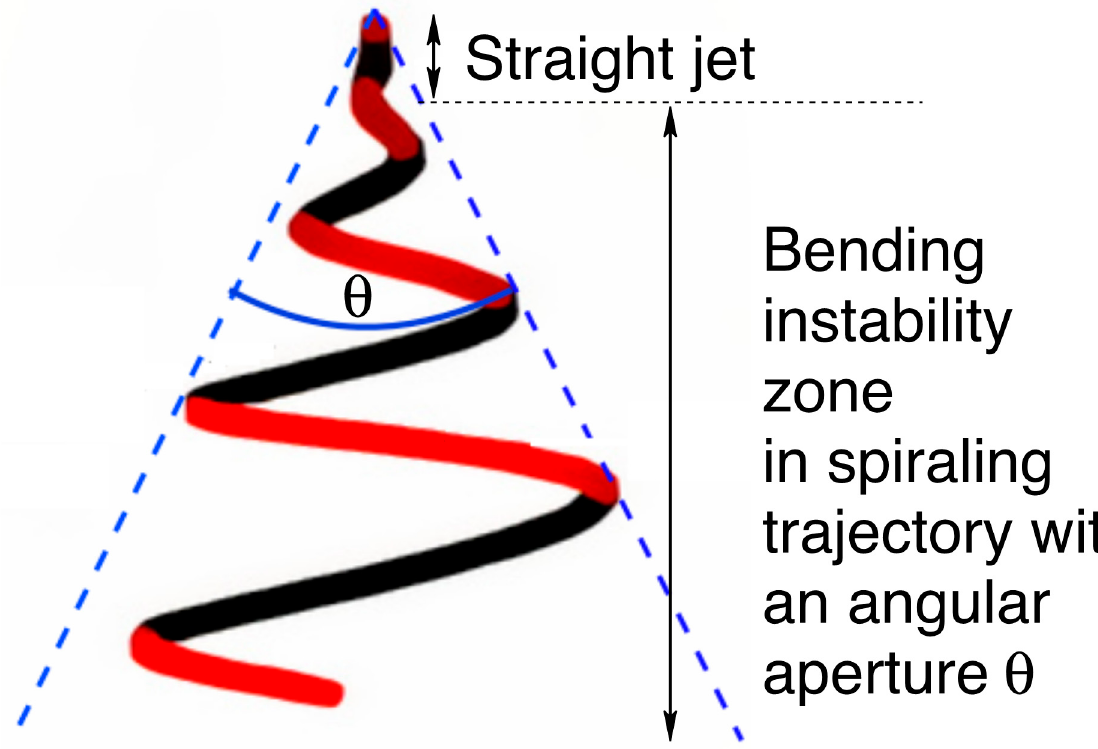
Figure 1. Electrospinning jet trajectory.